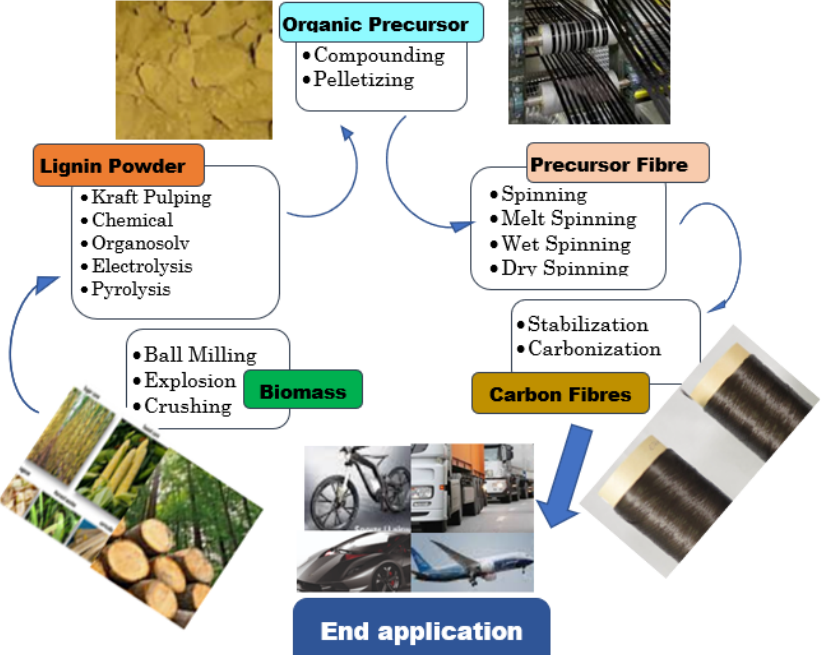
Figure 2. The conceptual flowchart of Lignin- based carbon fibre Processing Route through to end application.